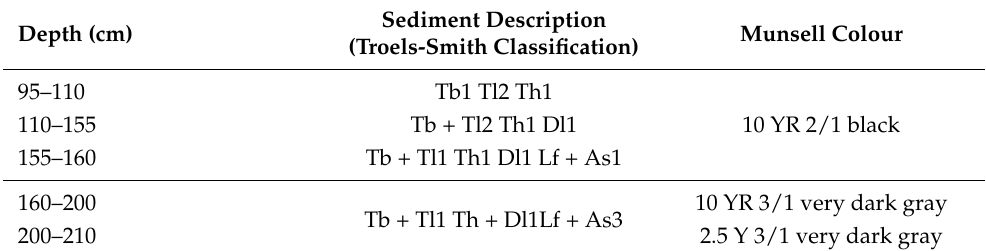
Table 1. Stratigraphy and description of the clay/peat deposits of the drilled core from the Blatuša mire. The different sediment components (total sum is 4) are: As—clay, Dl—woody detritus (>2 mm), Lf—iron oxides or sulphides, Tb—moss peat, Th—herbaceous peat, Tl—woody peat. Depth